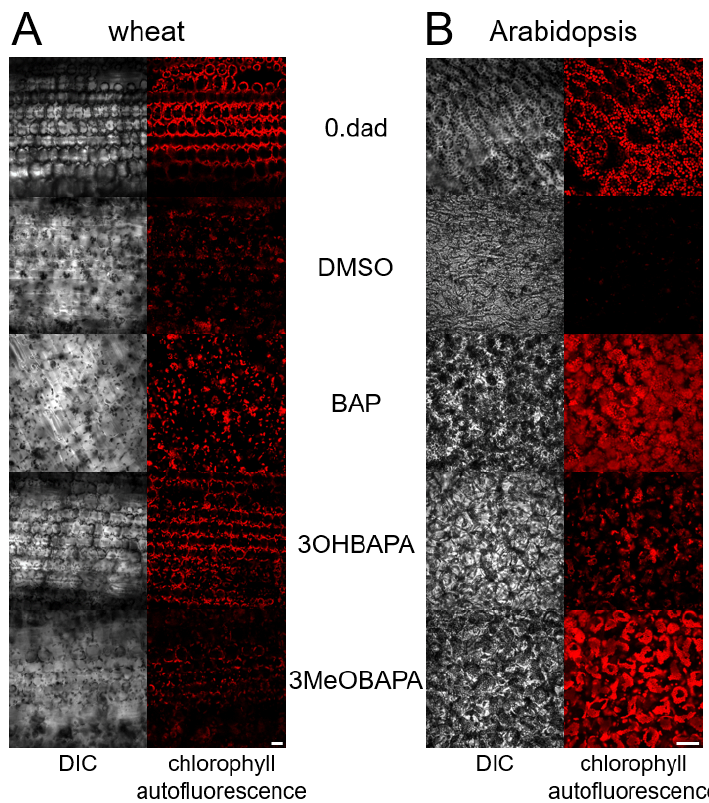
Figure 3. Confocal micrographs of freshly detached (0. dad) ( A ) wheat and ( B ) Arabidopsis leaves and leaves incubated in 0.1% DMSO or 10-µmol·L − 1 solutions of BAP, 3MeOBAPA and 3OHBAPA in the dark for 6 days. Scale bars represent 50 µm. DIC, differential interference contrast.